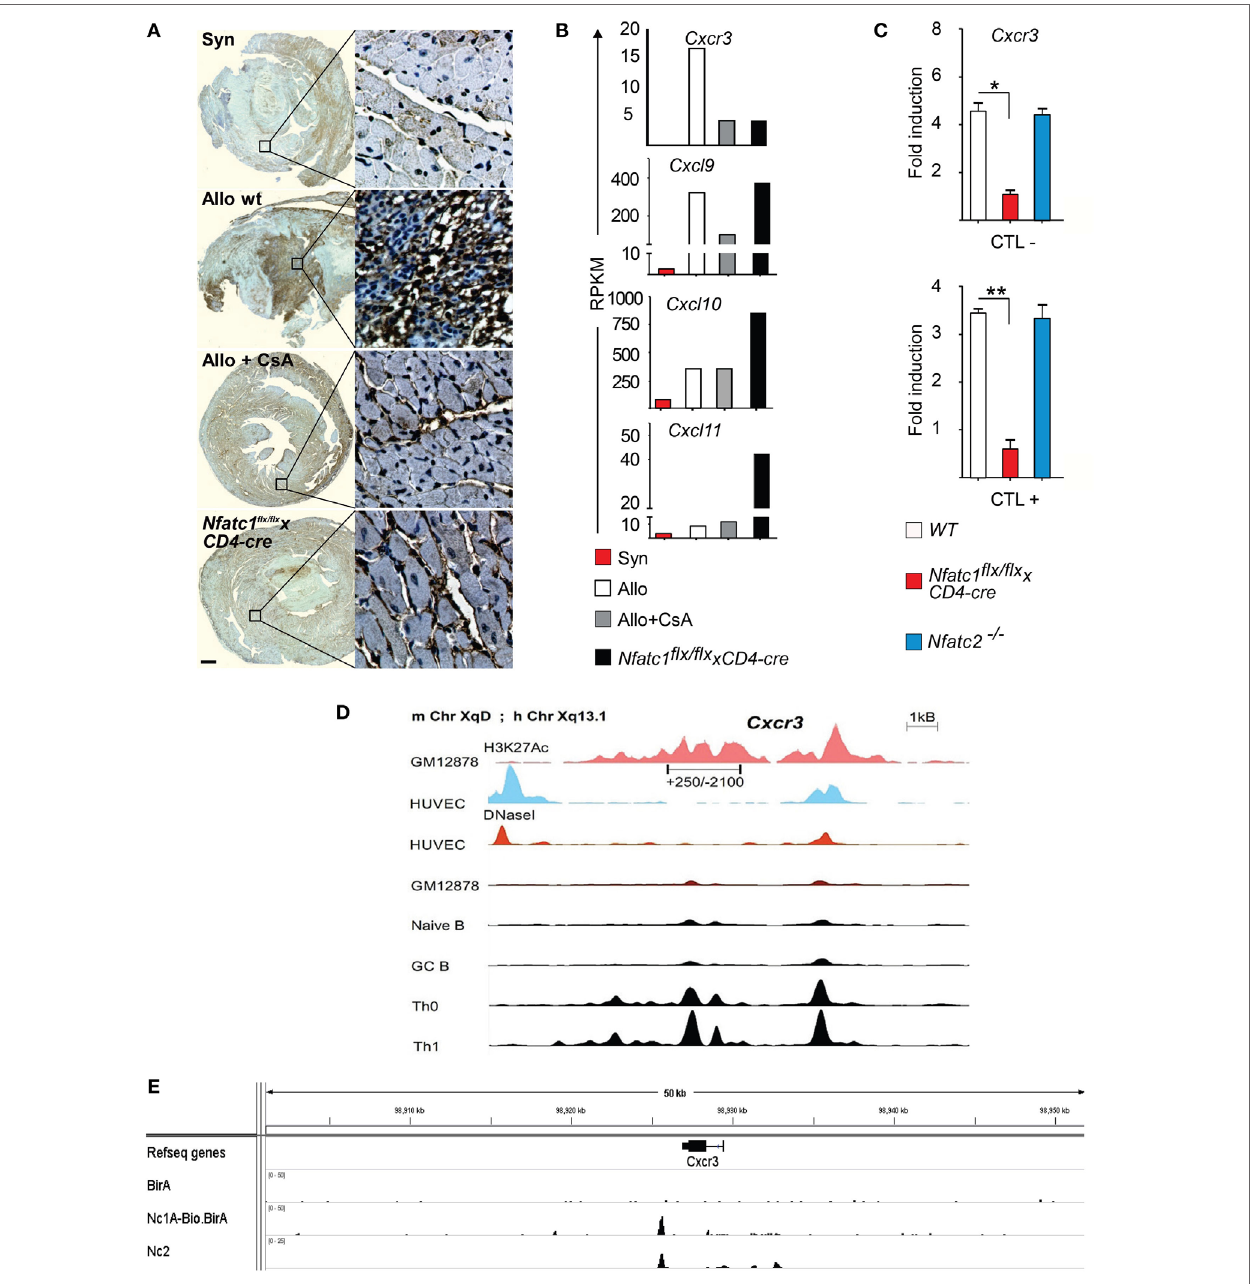
FigUre 5 | The Cxcr3 gene is a direct NFATc1 target. (a) Representative immune histochemical stains of Cxcr3. Syngeneic (Syn) or allogeneic (Allo) heart grafts were transplanted into wild-type (WT) or cyclosporin A (CsA)-treated WT mice, or in recipient mice bearing NFATc1-deficient T cells ( Nfatc1 flx/flx x CD4-cre ). Grafts and graft-infiltrating cells (GICs) were analyzed during the acute rejection phase on day 5. Bar, 500 µm. (B) Next-generation sequencing assays. Normalized RNA expression of Cxcr3 gene and of relevant ligand genes— Cxcl9 , Cxcl10 , and Cxcl11— in the transcriptome of GICs. RPKM, reads per kilobase per million reads. (c) Induction of Cxcr3 transcripts in CTL cells derived from WT, Nfatc1 flx/flx x CD4-cre or Nfatc2 − / − mice. Real-time PCR assays of RNAs were normalized to Actb expression. (D) Genomic organization of the Cxcr3 locus. The distribution of epigenetic modification histone mark H3K27Ac and the presence of DNaseI hypersensitive sites in non-expressing and cells expressing (as Th1 cells) is indicated. (e) Binding of NFATc1/A-Bio and NFATc2 (39) to the Cxcr3 locus in CTLs. ChIP seq assays using a bacterial artificial chromosome transgenic mice expressing NFATc1/A-Bio protein (see Figure S4 in Supplementary